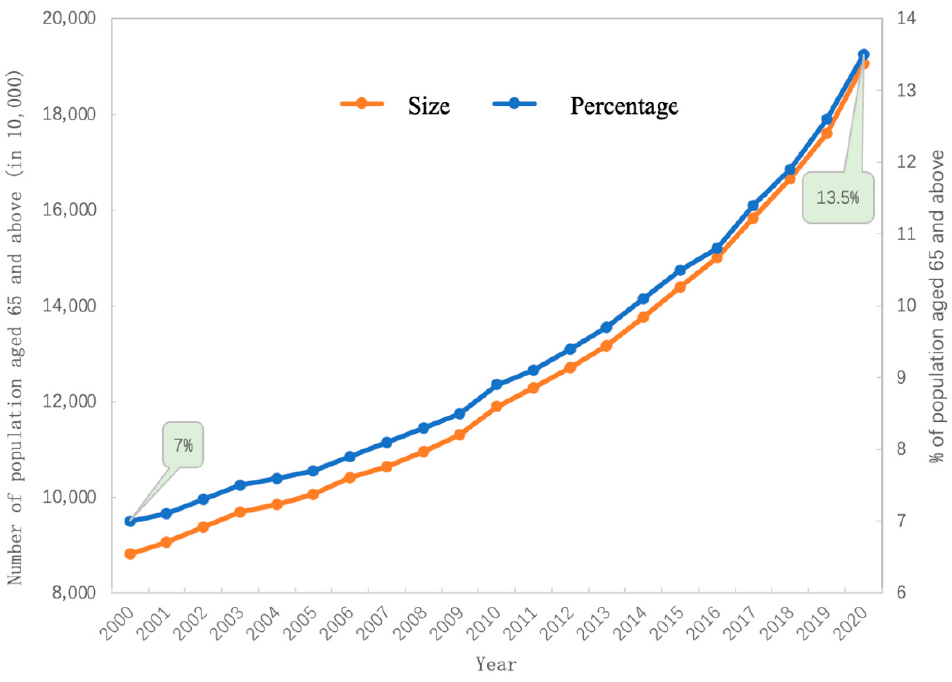
Figure 1. Trend of population aging in China.